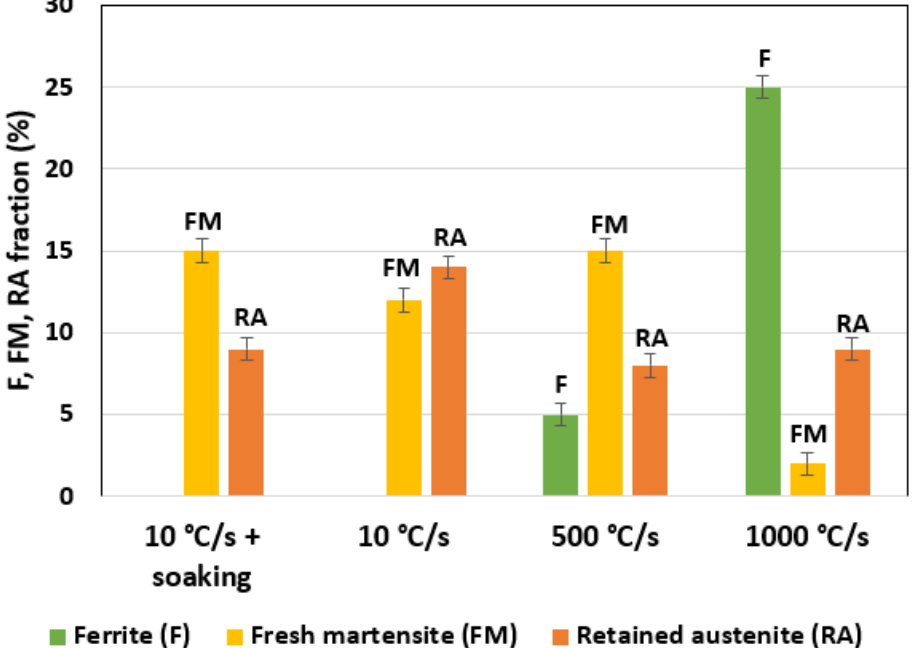
Figure 12. Microstructural evolution for different heating rates (data from [40]; steel chemical composition: 0.25% C + 1.2% Si + 3.0% Mn).